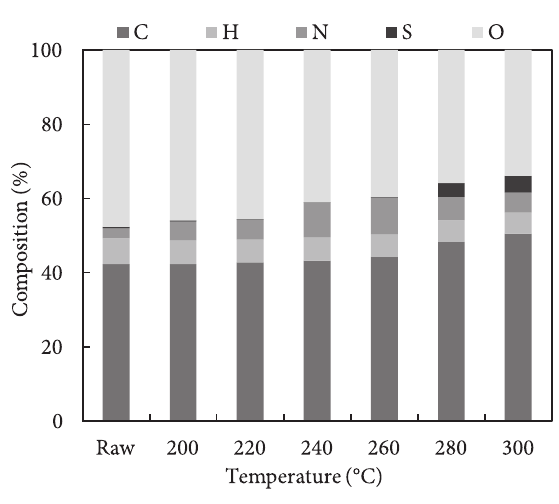
Figure 4. Ultimate analysis for OPF